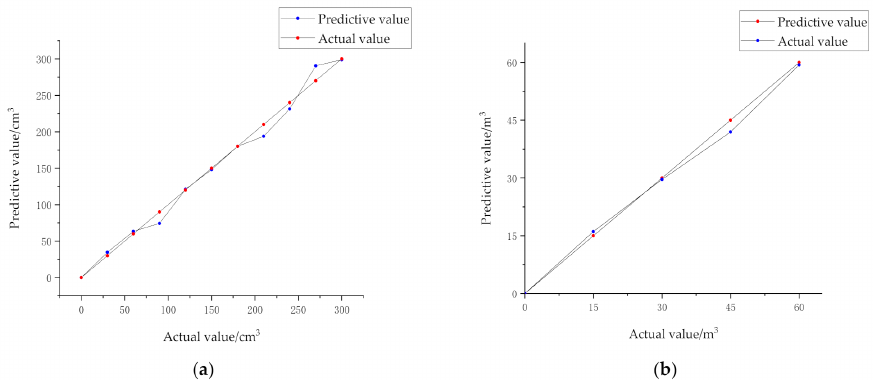
Figure 9. Actual value-predictive value line chart: ( a ) Data in a laboratory environment; ( b ) Data in an open-pit